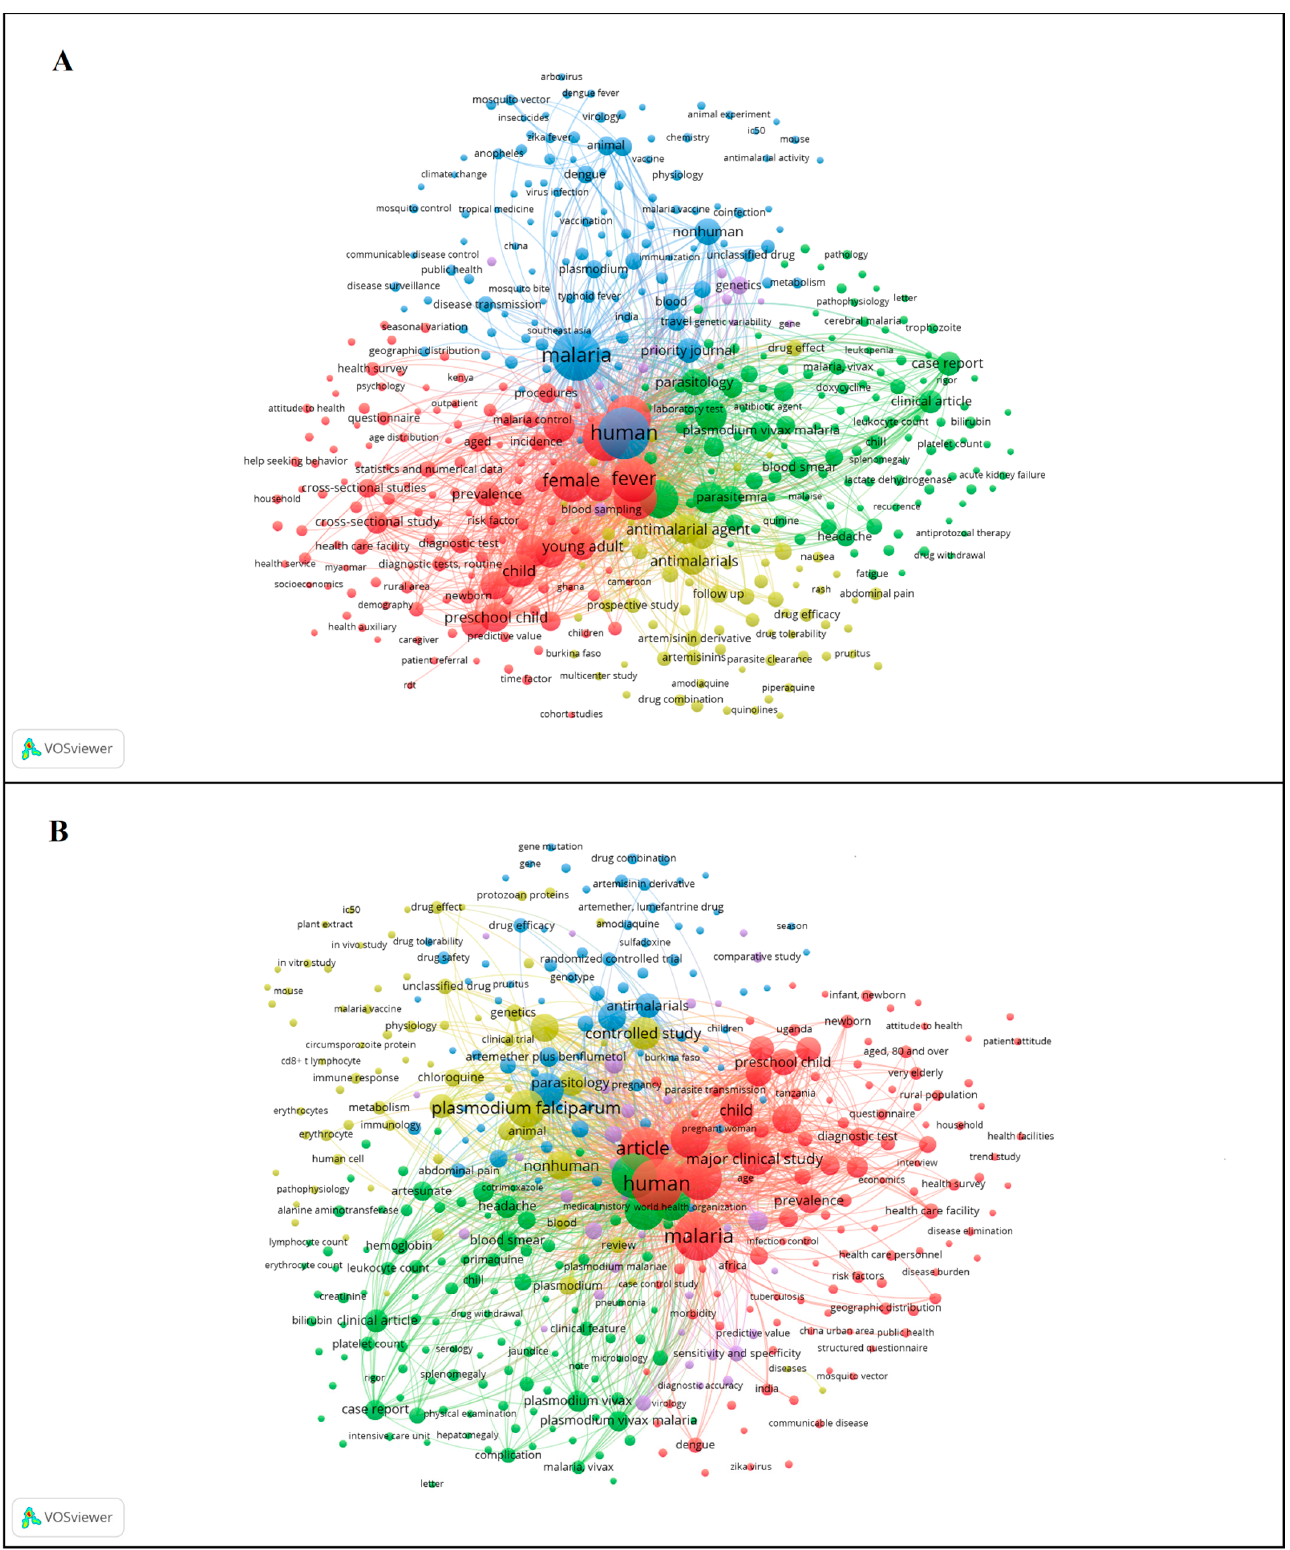
Figure 5. Keywords frequently used in malaria publications ( A ) before the COVID-19 pandemic, ( B ) during the COVID-19 pandemic.